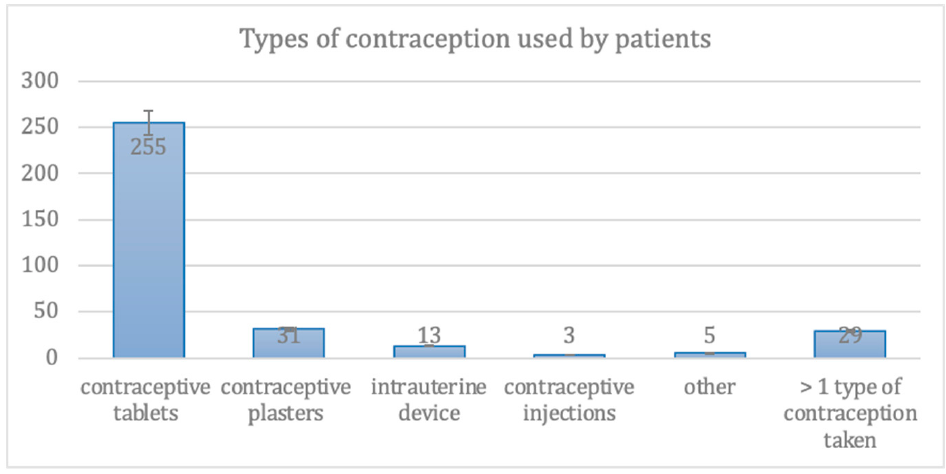
Figure 1. Types of contraception used in the group of patients who use contraceptives.